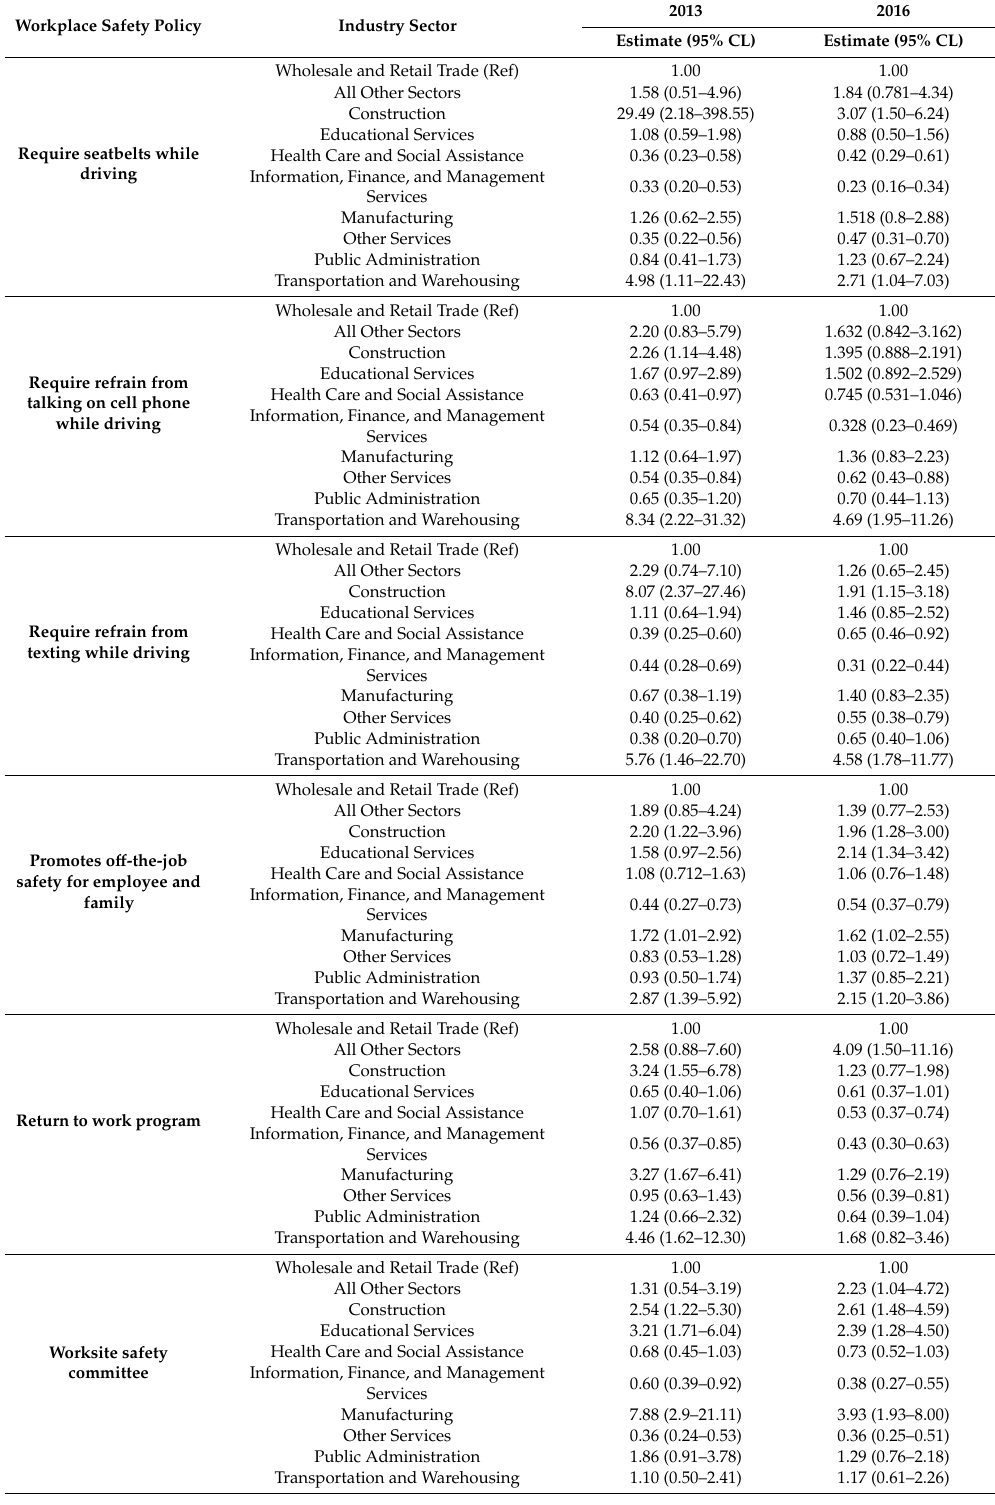
Table 5. Multivariable regression model of implementing workplace safety policies by sector, stratified by year and industry